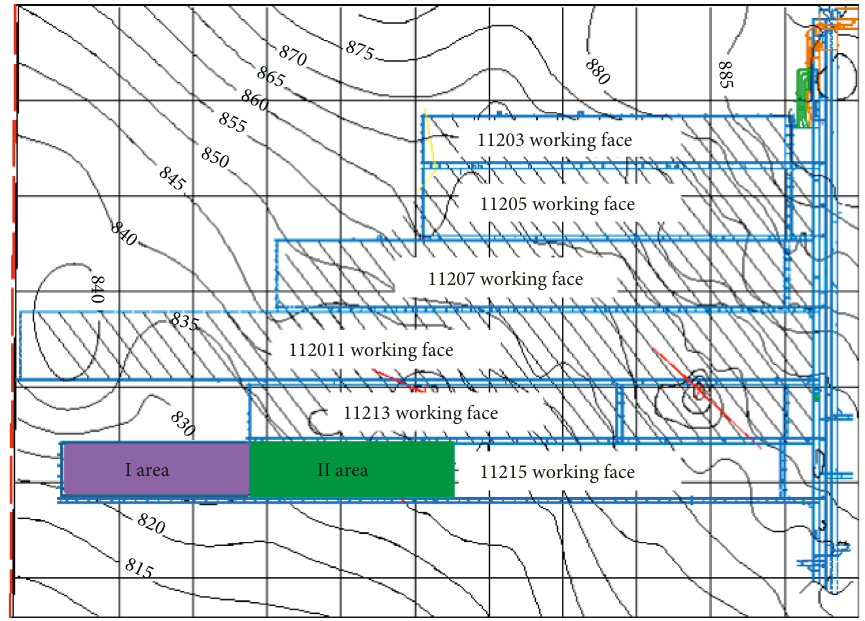
Figure 1: Mining engineering plane